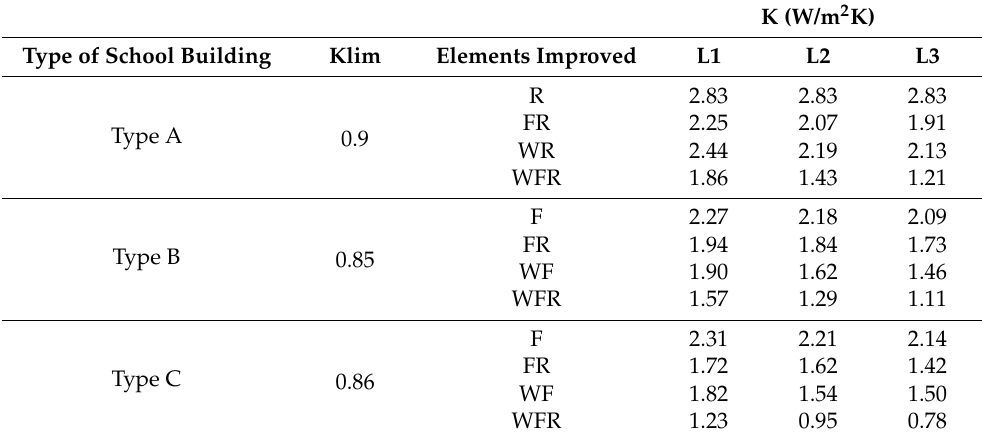
Table 9. Global heat transmission ratio K (W/m 2 K). Regulatory requirements according to type of school building, building compactness and climate zone, Klim and ratios obtained for each set of measures and energy demand level.